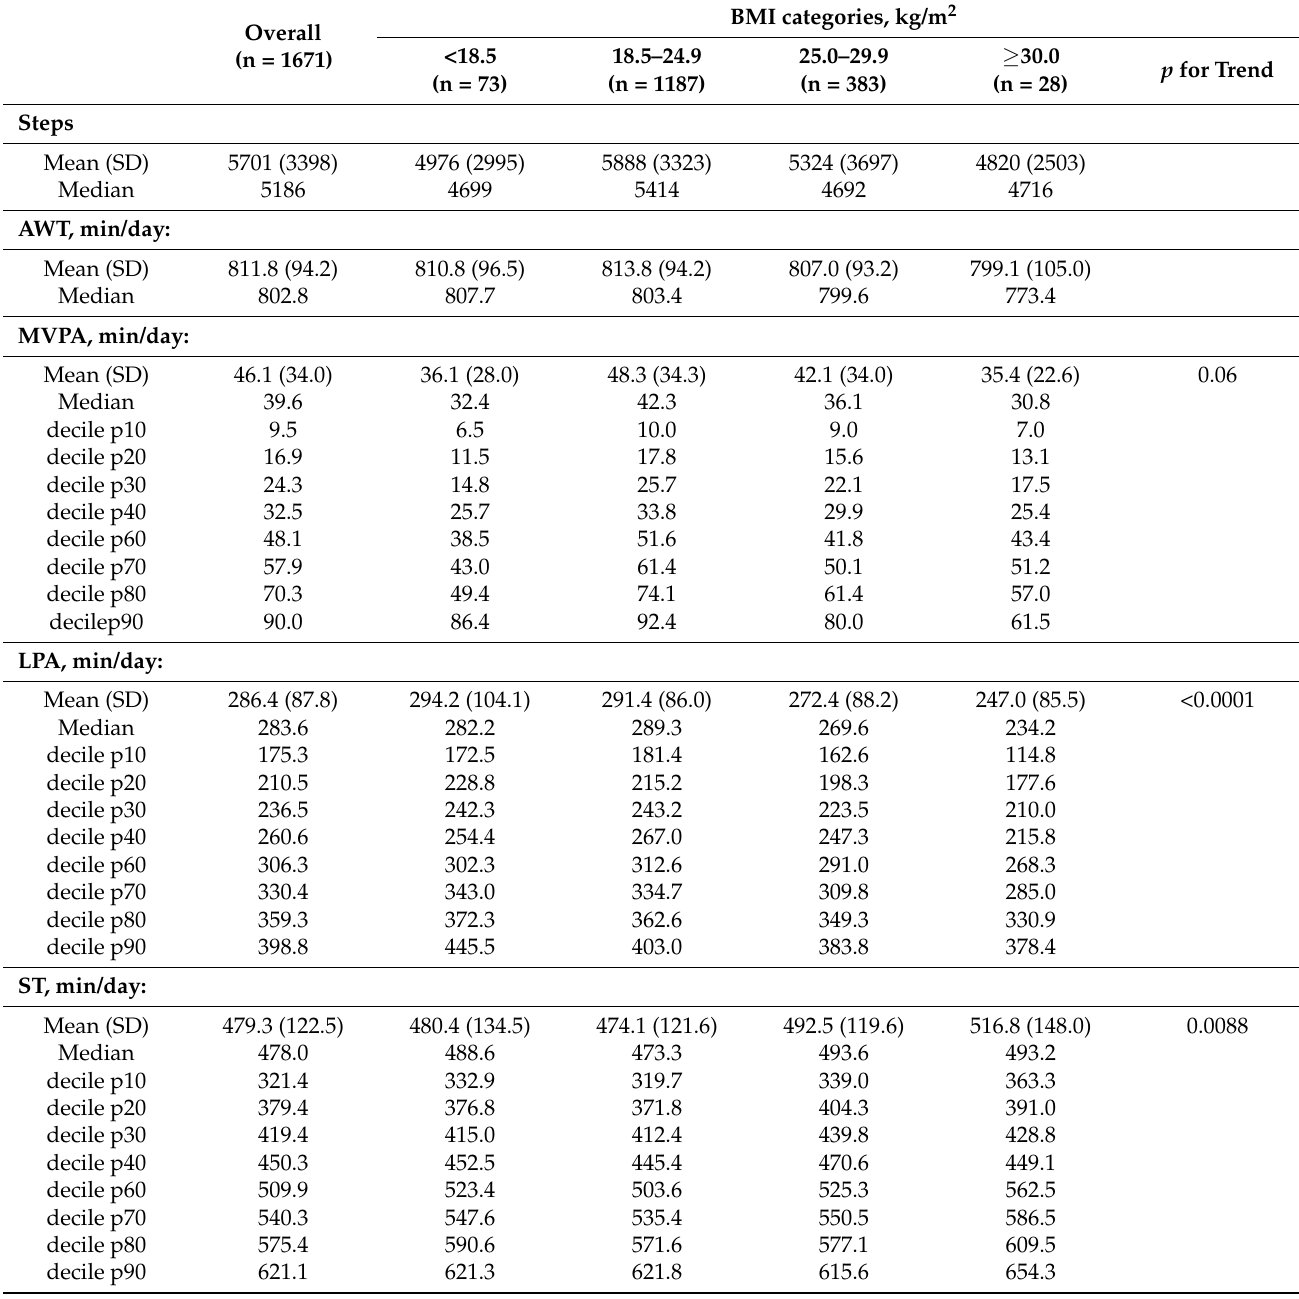
Table 3. Tri-axial accelerometer-determined PA and ST by BMI groups in the men (n =